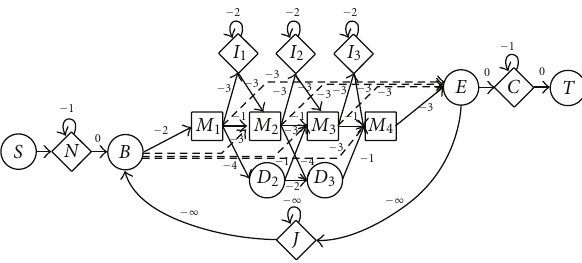
Figure 2: A profile HMM with 4 nodes and the transition